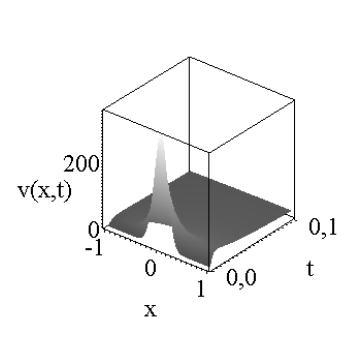
(cid:18) (cid:19) x g for the paramter set of 1 1 t t 2 2